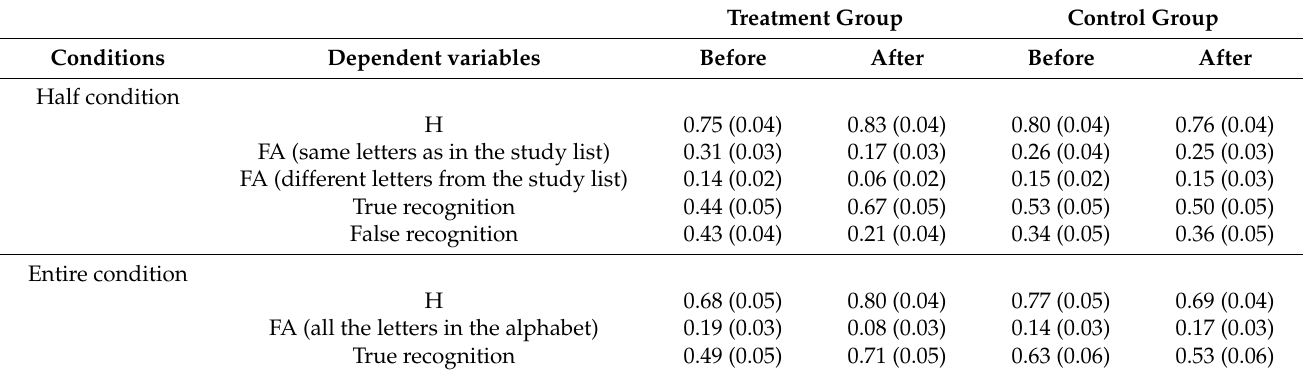
Table 1. Means (and SE s) of hits (H), false alarms (FA), and estimations of true and false recognition. Treatment Group Control